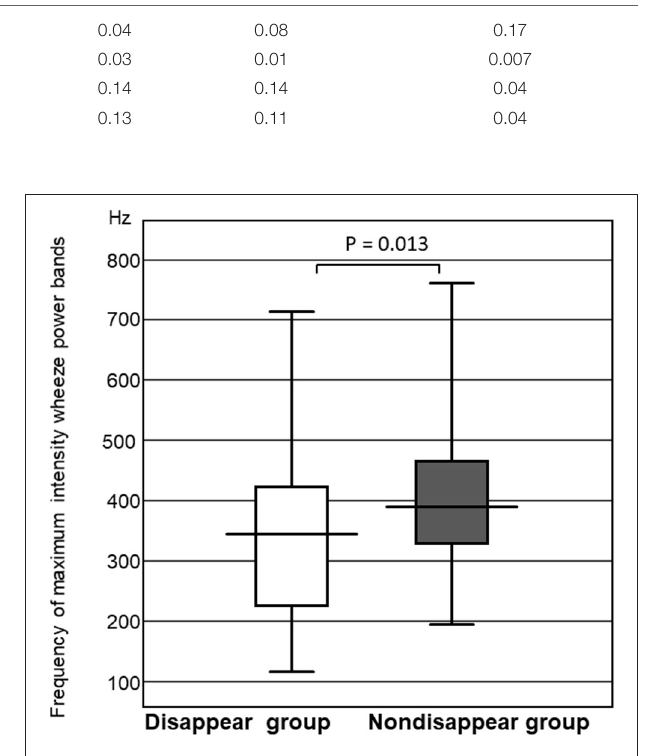
wheeze power bands in the non-disappear group was 396.1 ± 136.7 Hz, whereas that of the disappear group was 331.3 ± 175.7 Hz ( Figure 4